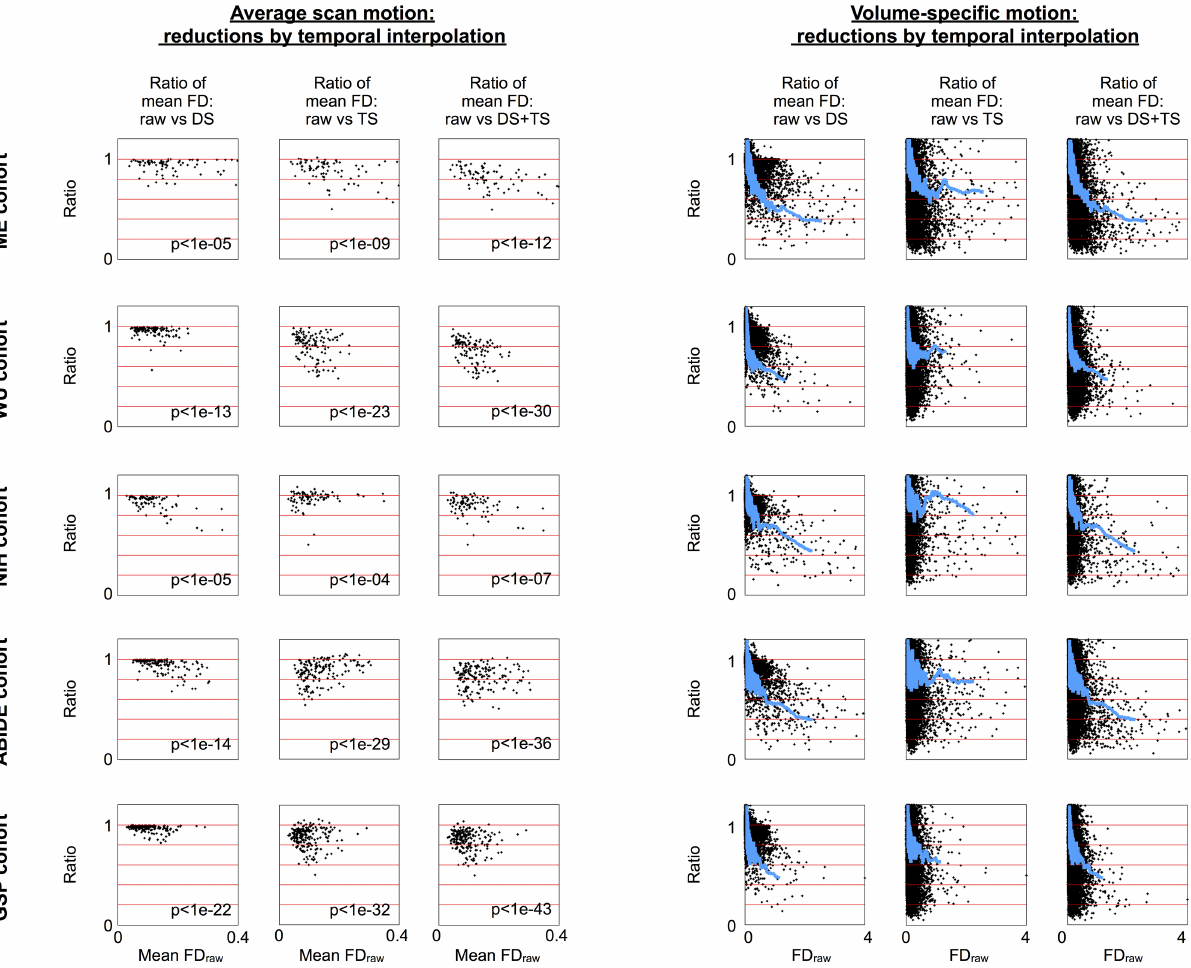
Fig 3. Temporal interpolation tends to reduce estimated brain motion in fMRI scans. Data for 5 cohorts are shown. At left, mean motion in a scan is shown for each subject estimated both before and after temporal interpolation. At right, each volume’smotion is shown in a similar mannerwith a blue smoothingcurve over 2000 points. Raw FD forms the x-axis; the y-axis is the ratio of post-temporal-interpolation motion relativeto the raw FD value. Inset p values are from paired t-tests of raw versus post-interpolationmean FD values.